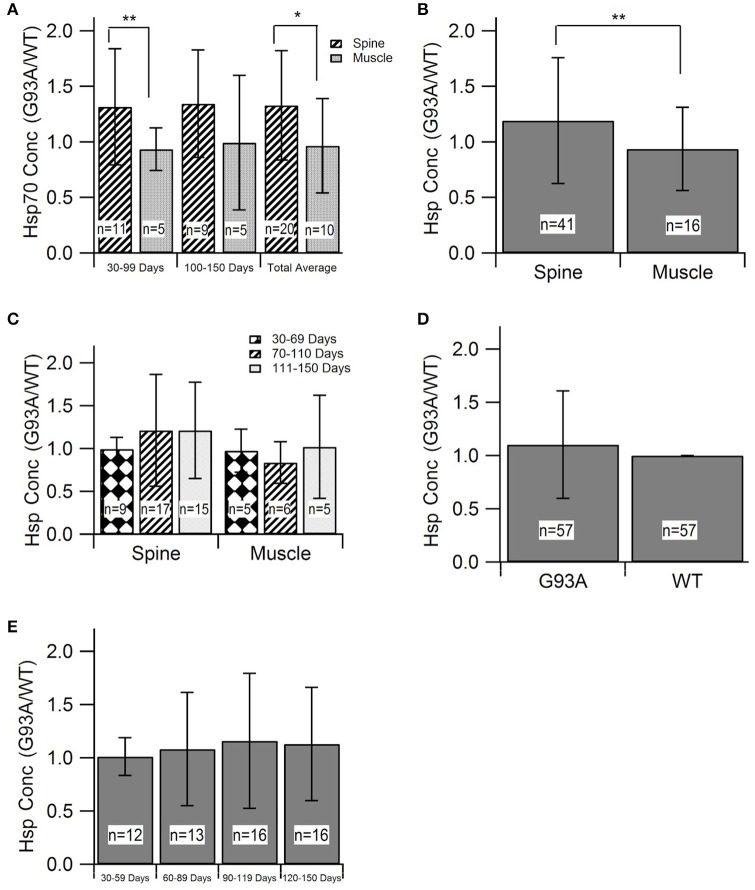
Heat-Shock Protein (HSP) concentration during disease progression in spine and muscle tissue samples from SOD1-G93A mice. Mann-Whitney U-Tests were used to determine any significance in all figure parts. (A) The G93A/WT ratio of HSP70 in the spine and muscle for three age groups. (B) The aggregate G93A/WT ratio of HSP70 concentration in the spine and muscle. (C) The G93A/WT ratio of overall HSP levels in the spine and muscle for three age groups. (D) The aggregate G93A/WT ratio of overall HSP concentration in the spine and muscle. (E) The G93A/WT ratio of overall HSP concentration for all locations combined and aggregated by age group. **p < 0.05, *p < 0.10.